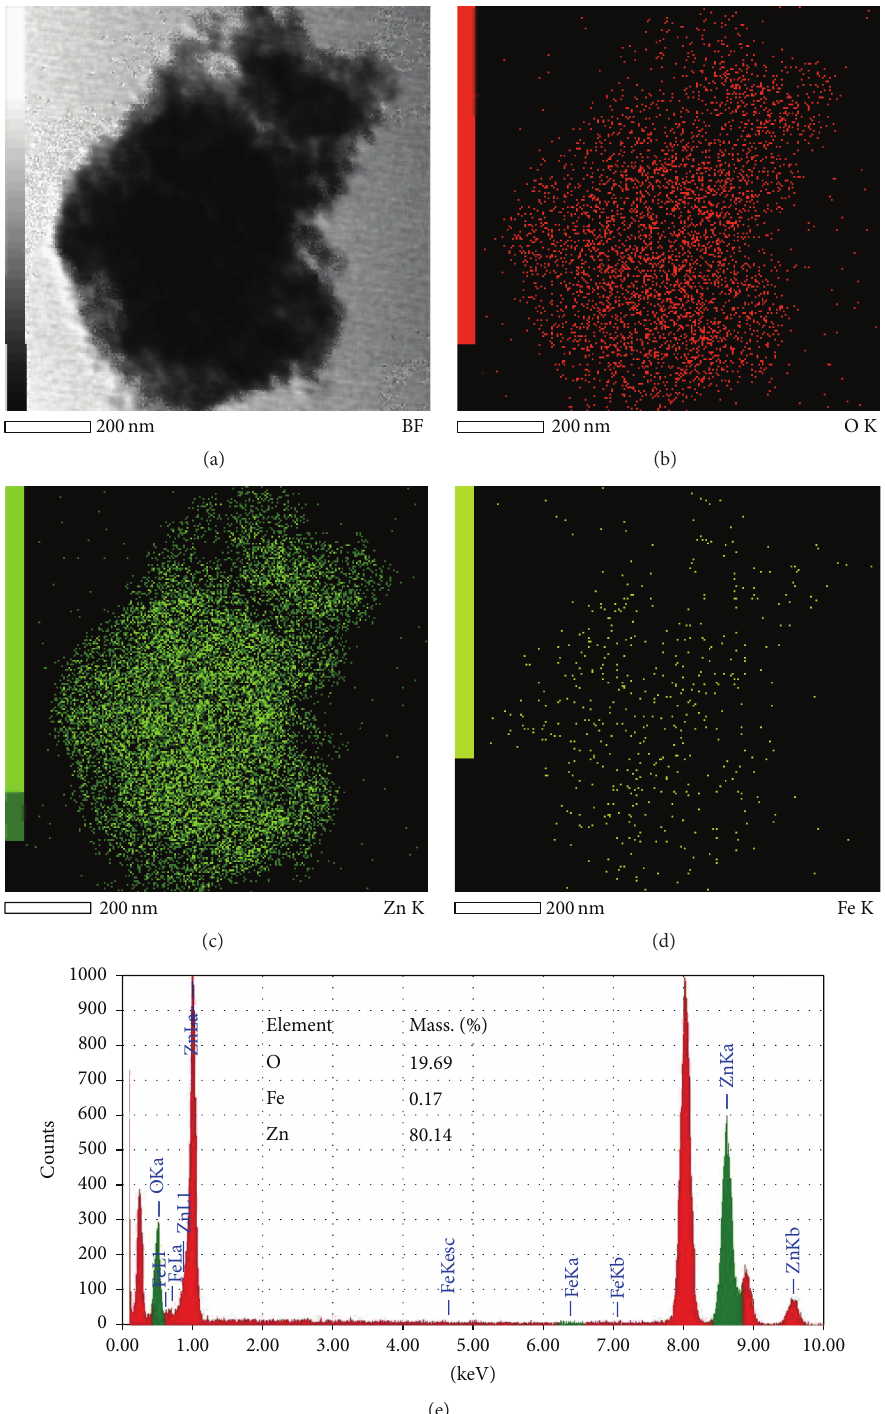
Figure 4: (a) STEM image of ZnO-Zn-Fe sample; (b), (c), (d) the corresponding EDX mappings of O, Zn and Fe; (e) EDX spectra of sample